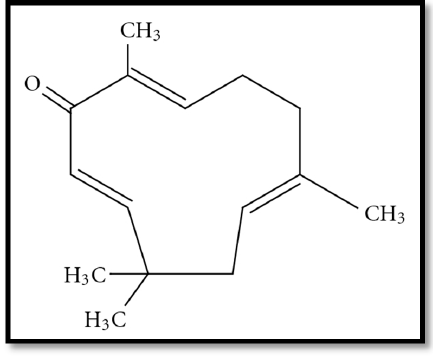
Figure 1. Chemical structure of ZER [28].